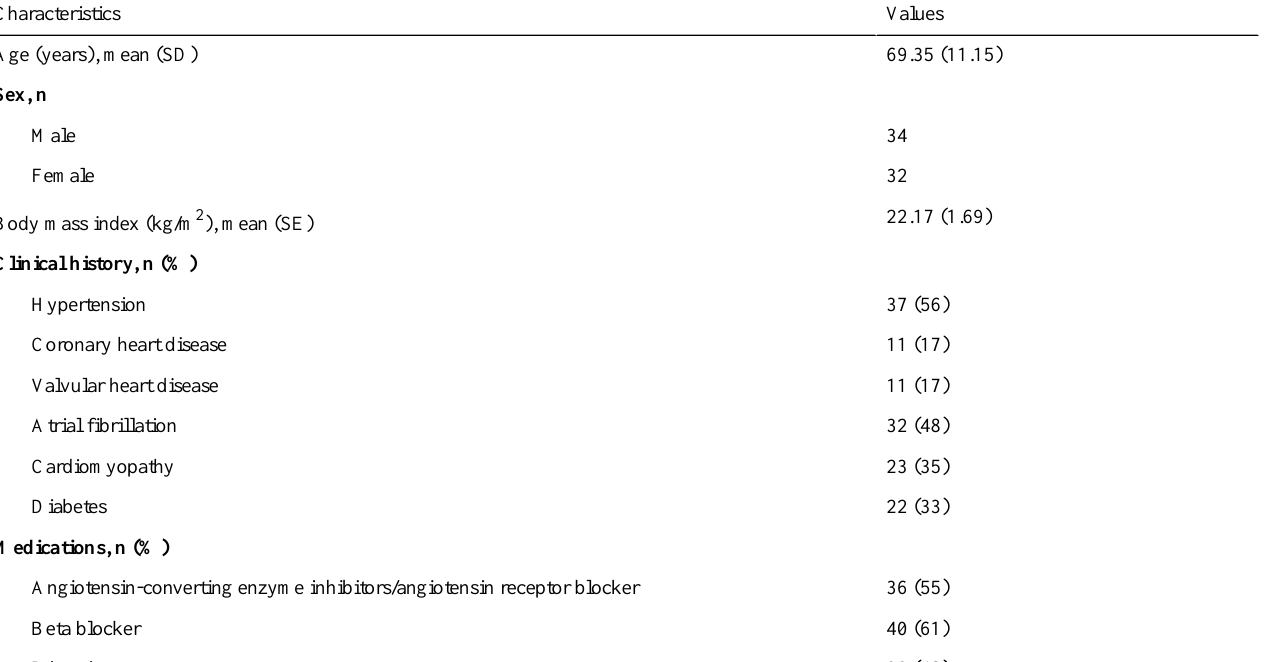
Table 1. Baseline demographic characteristics of the study participants.